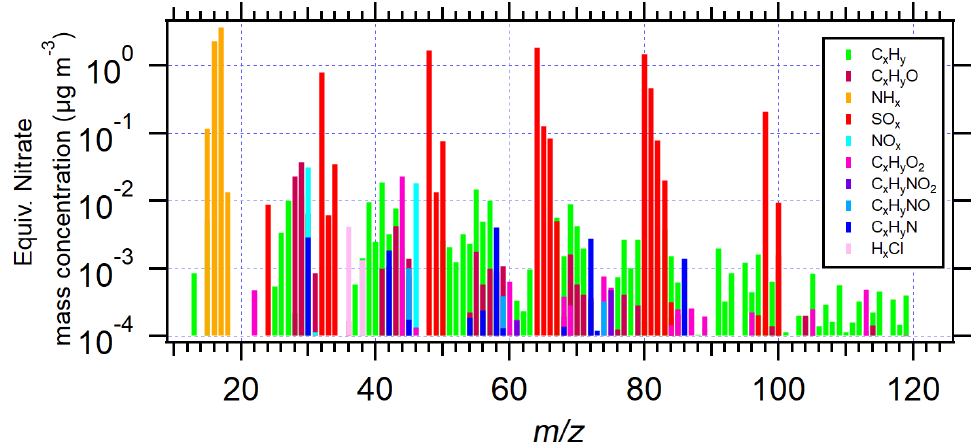
Figure 3. Unit-mass resolution spectra (averaged over 12 measurements, converted from the high-resolution data) of AS aerosol particles ( d a = 200nm) in EXP P1, performed at an AS concentration of 0.5M.